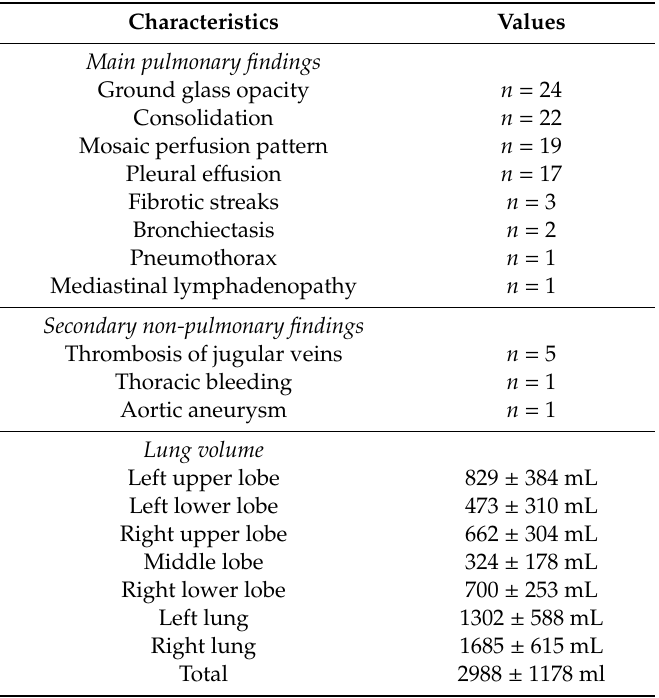
Figure 3. Large areas of perfusion defects in both lungs with ground glass opacities. The mean lung volume according to automatic evaluation was 2988 ± 1178 mL. Further details on the study group are displayed in Table 3. Lung volume was negatively correlated with perfusion defects, with a Pearson correlation coe ffi cient of − 0.67 for the left lung and − 0.60 for the right lung. Table 3. Imaging findings and lung volume analysis.